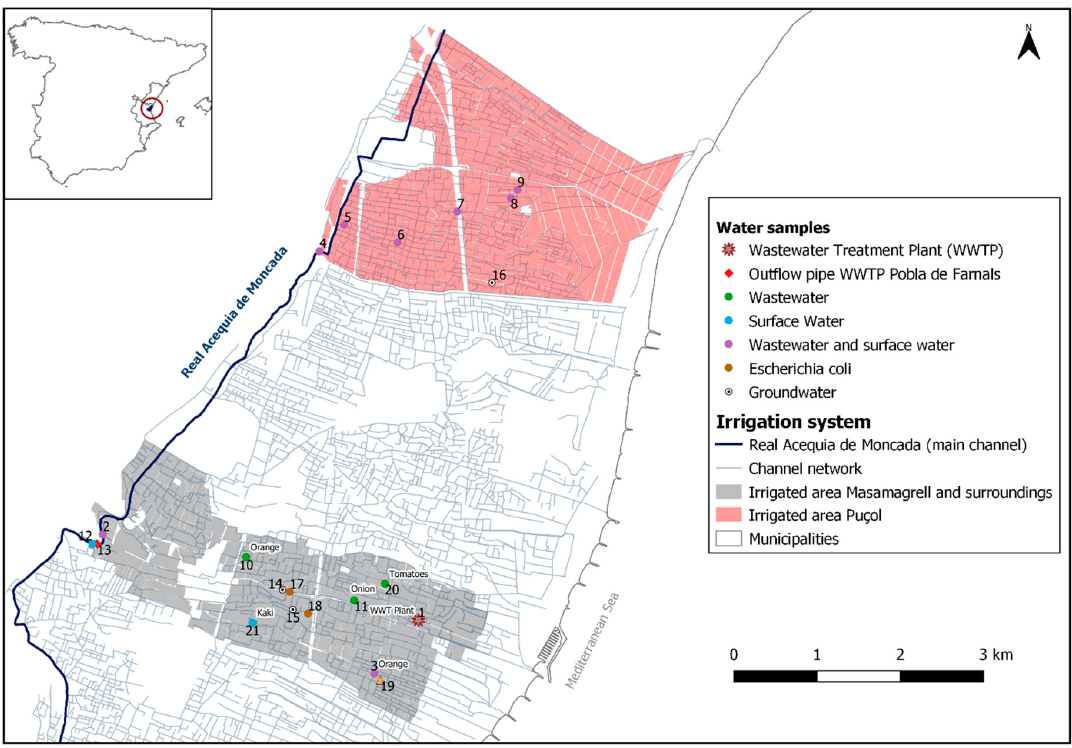
Figure 1. Studied area with measurement points.